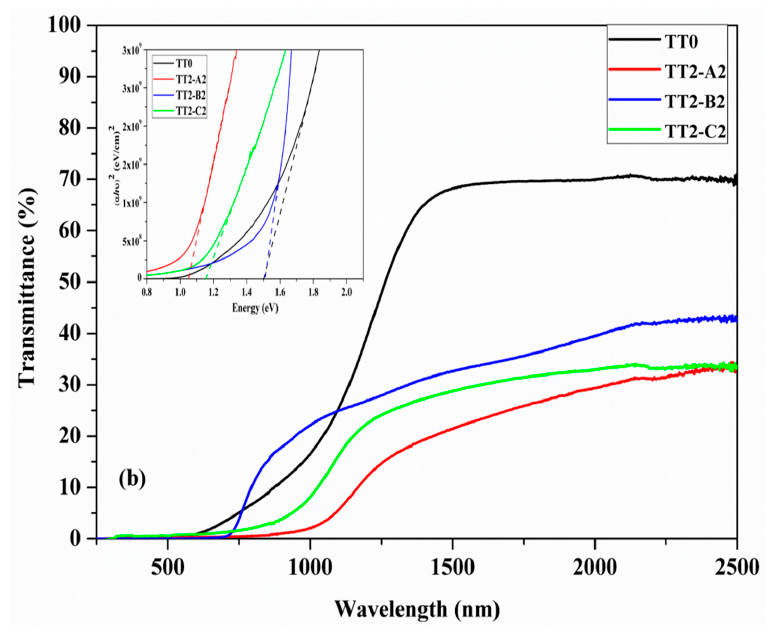
Figure 5. The ultraviolet-visible (UV-Vis) transmittance spectrum of CZTS samples ( a ) TT0, TT1-A1, TT1-B1 and TT1-C1 ( b ) TT0, TT2-A2, TT2-B2 and TT2-C2 A2) and tauc plot for determination of band gap. Table 3. Resistivity of samples after different thermal treatments. The values of the band gap energy (Eg) and of the transmittance at 1500 nm after TT1 and TT2, the type of secondary phases detected by XRD after TT1 and by Raman after TT2 are also reported.